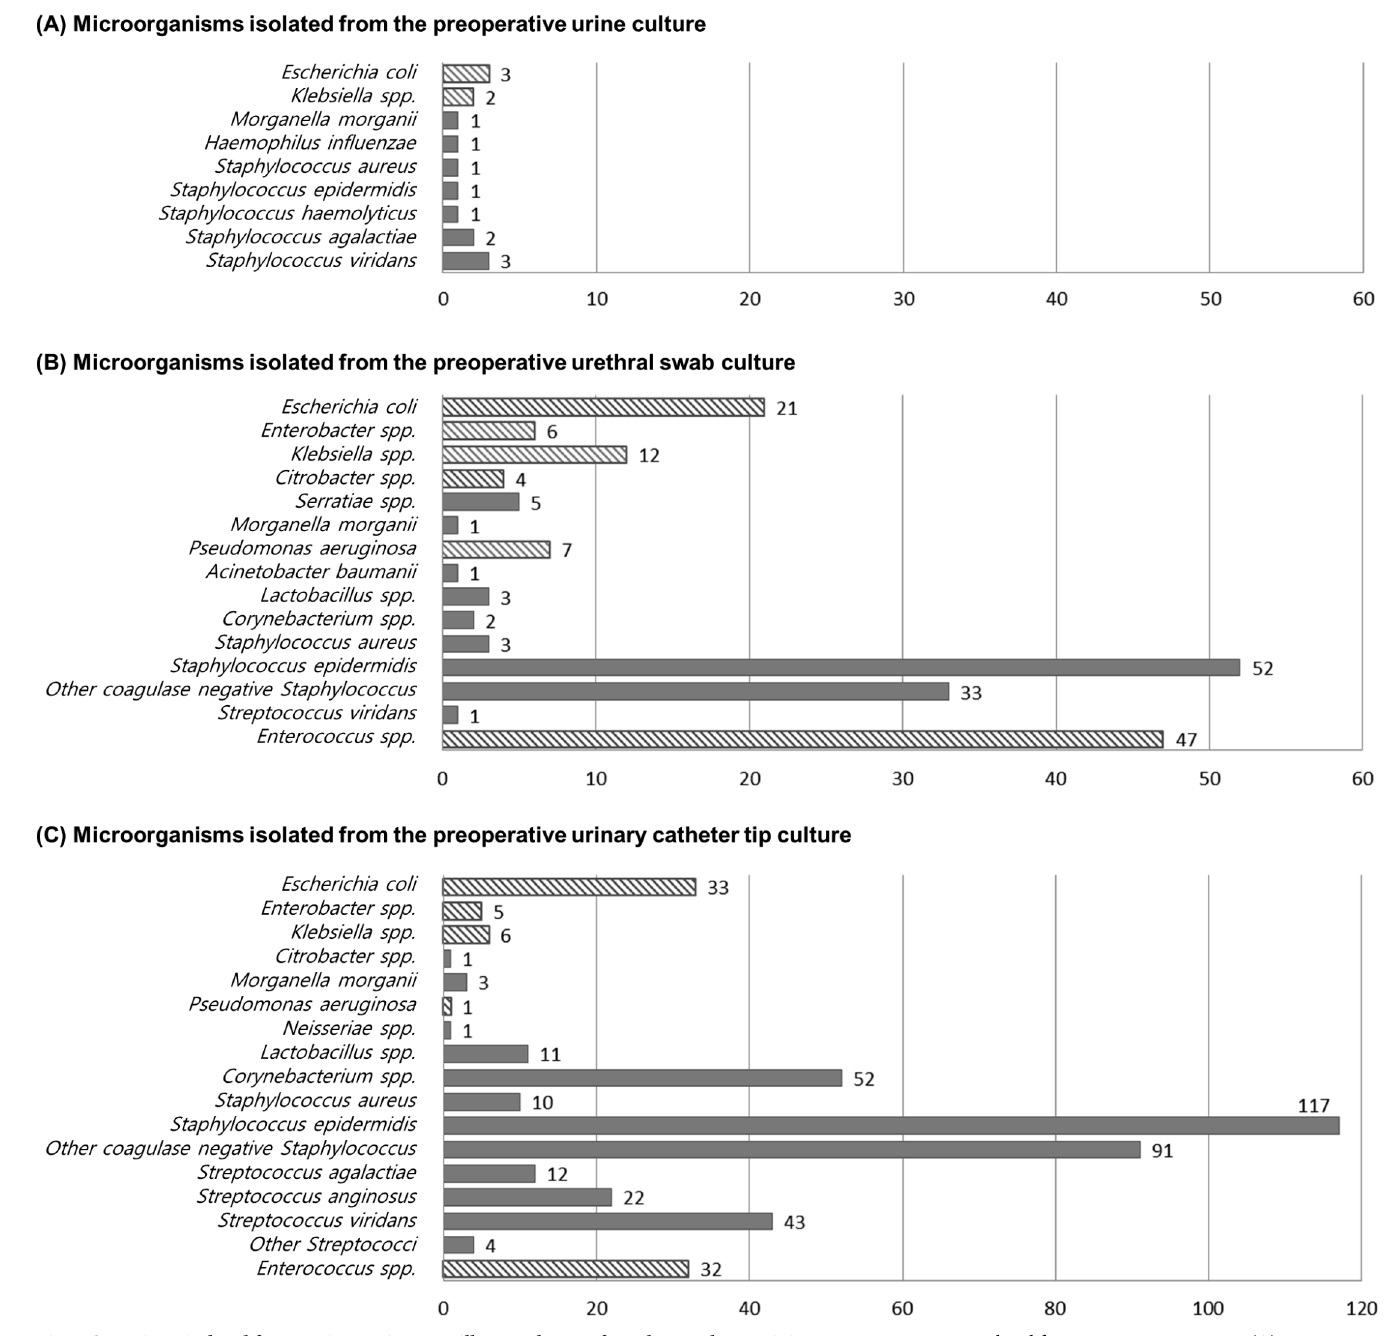
Fig 1. Organisms isolated from perioperative surveillance cultures of renal transplant recipients. Microorganisms isolated from preoperative urinary (A), preoperative urethral swab (B), and postoperative urinary catheter tip specimens (C). The shaded box depicts the common uropathogens.